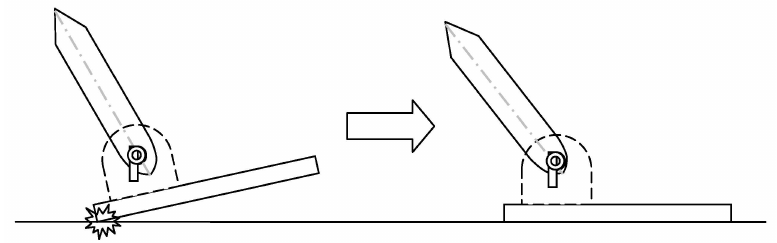
Figure 11. Foot landing with a compliance ankle joint.